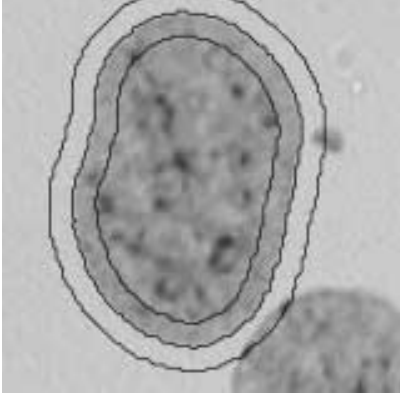
Fig. 6. Inner and outer border regions for intensity